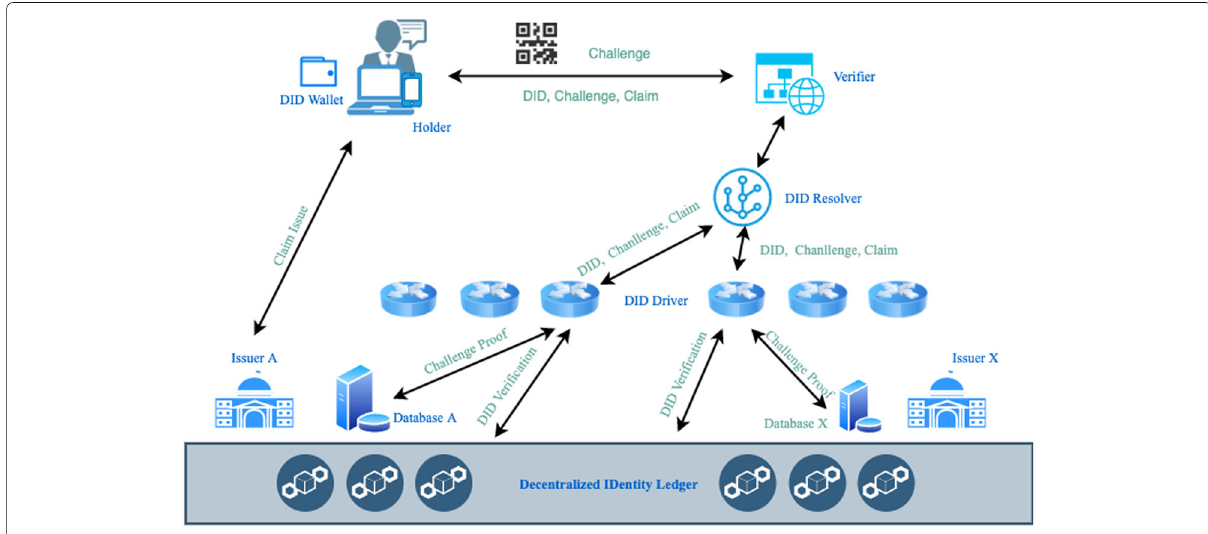
Fig. 7 The DID system proposed by